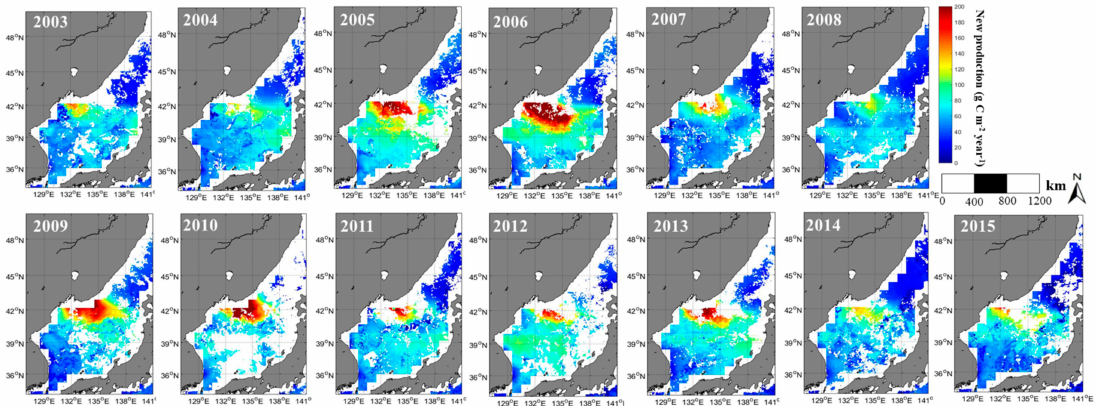
Figure 7. Long-term pattern of the annual new production in the East/Japan Sea (EJS) from 2003 to